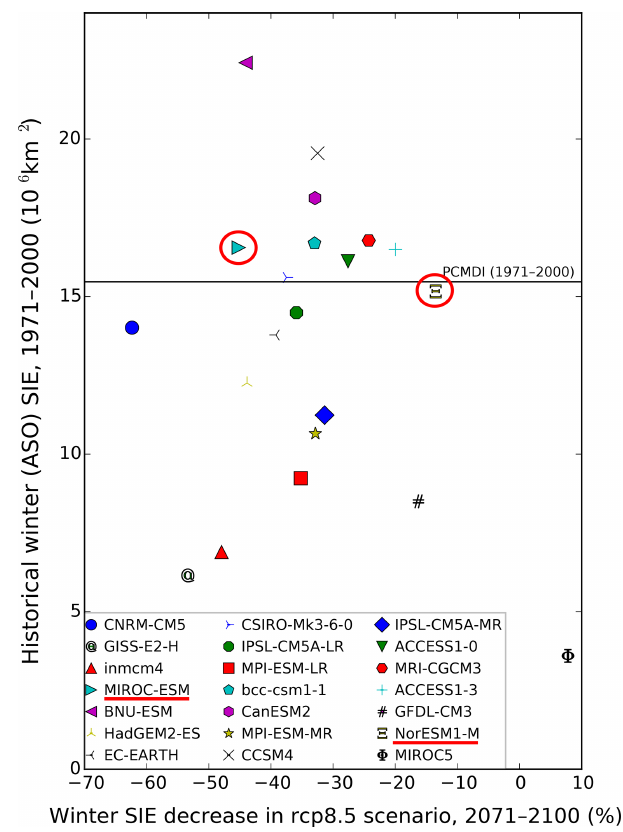
Figure 1. Historical Antarctic winter (August–September–October: ASO) sea ice extent (SIE, in millions of square kilometres) as a function of the relative decrease in winter SIE in the RCP8.5 projection for the period 2071–2100 with respect to the reference period 1971–2000. The mean winter SIE in the observations for the historical reference period is indicated by the horizontal black line (PCMDI 1971–2000). Models selected for this study are high- lighted in